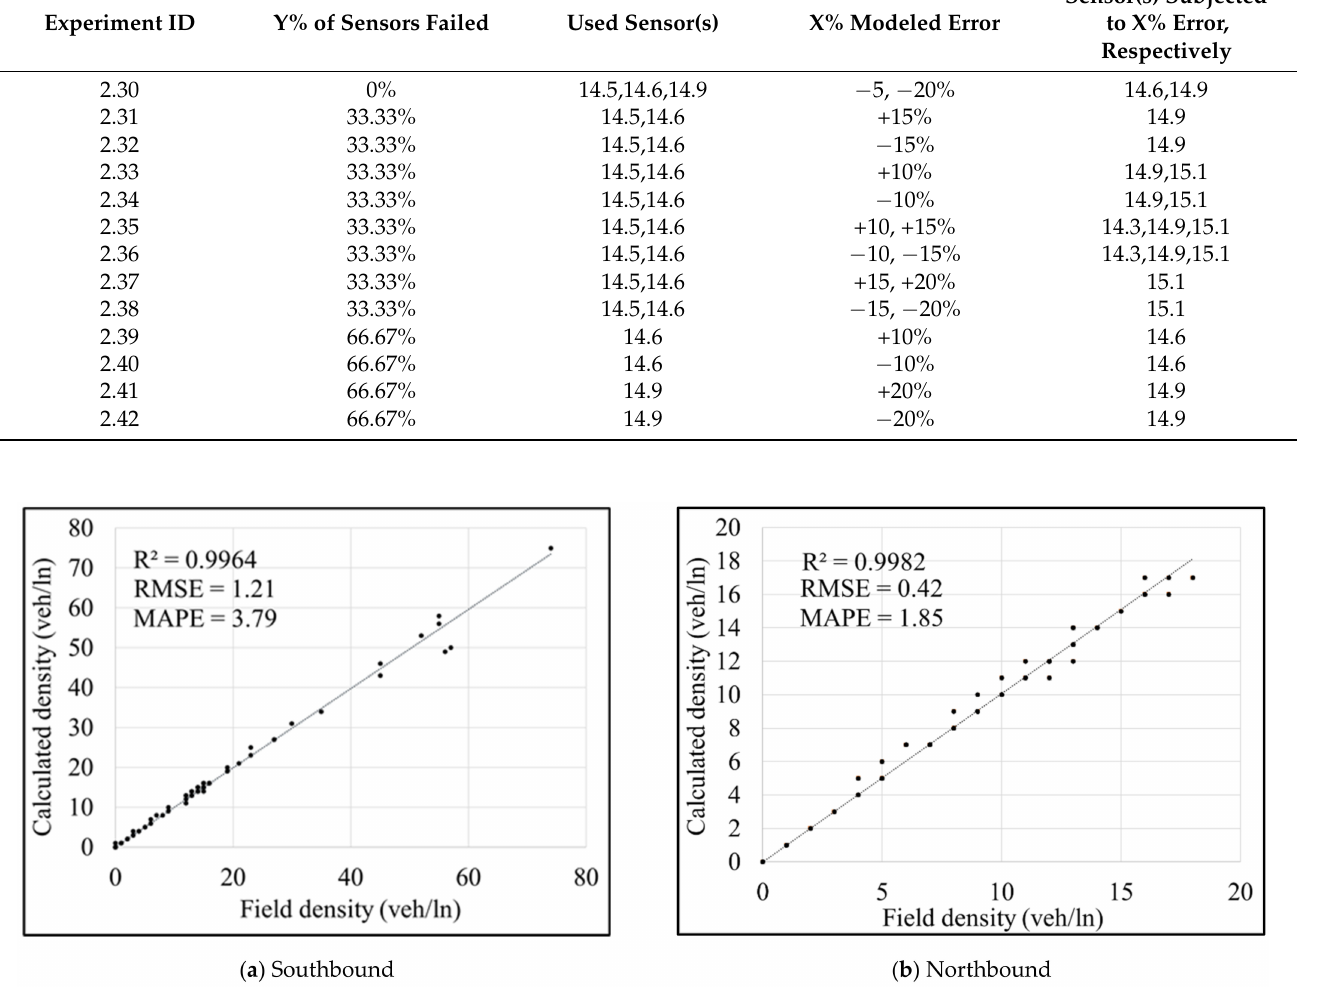
Figure 4. Results of density